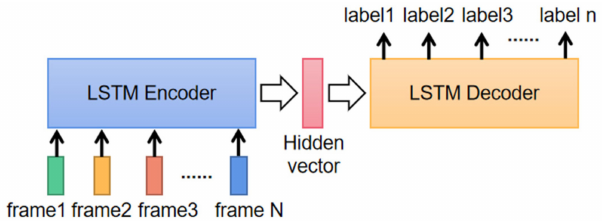
Figure 8. Encoder-decoder structured sequence recognition model.